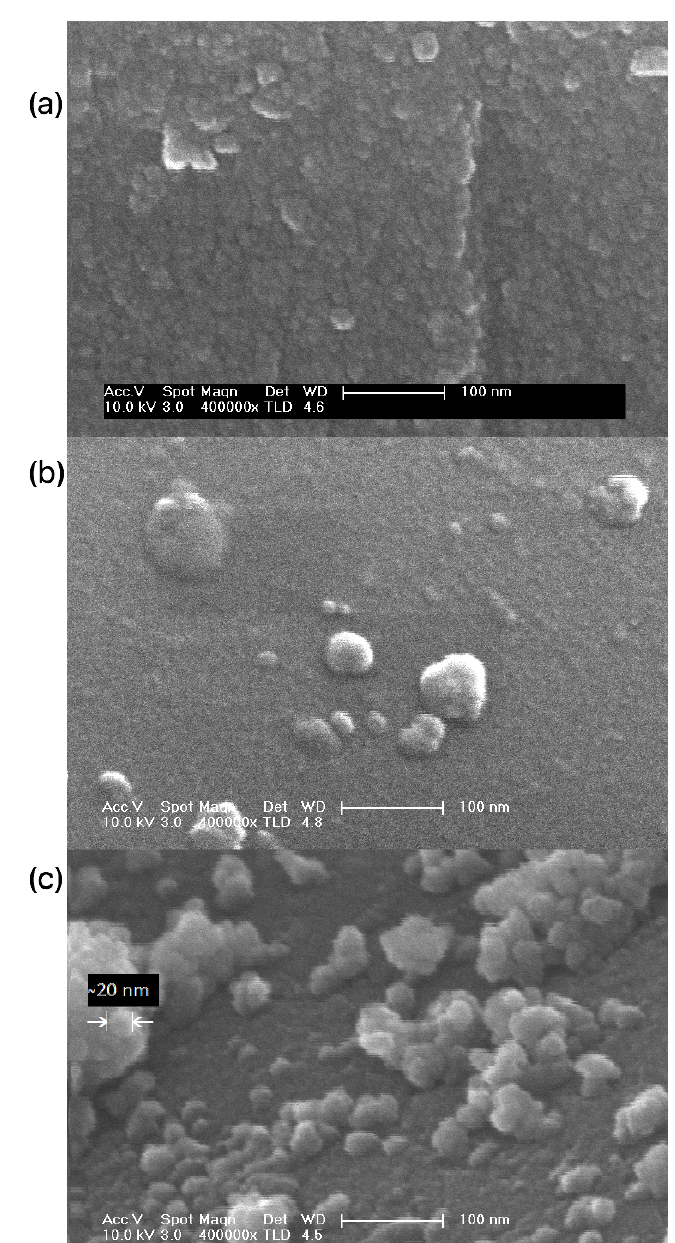
Figure 2. SEM micrographs of sol-gel nano-TiO calcined at different temperatures: ( a ) annealed 2 at 100 ◦ C, ( b ) 300 ◦ C, ( c ) 400 ◦ C. It can be observed that annealing can improve crystallinity of the nanoparticles through promoting grain growth and